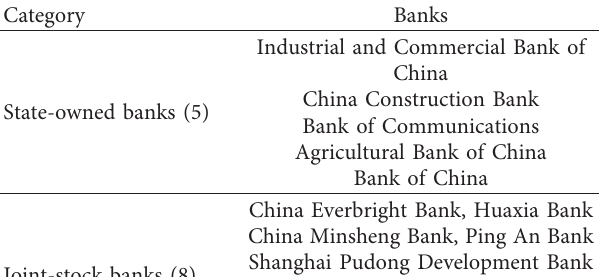
Table 10: Categories of different listed banks.